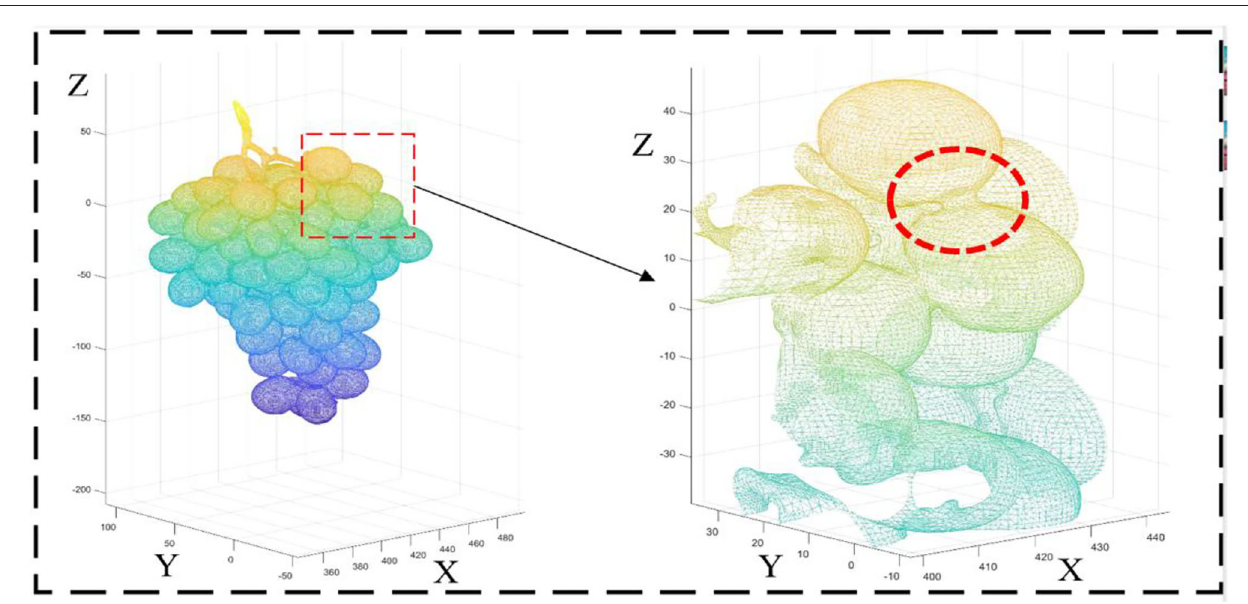
FIGURE 10 | Details of the Poisson reconstruction of the grape